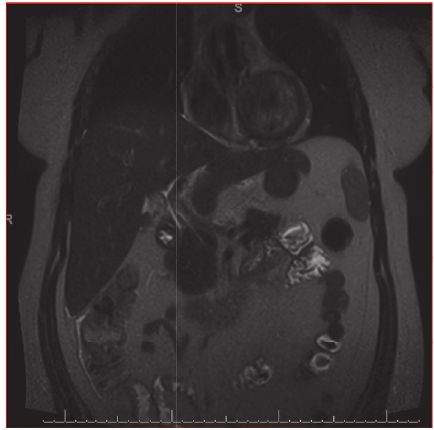
Figure 7: Postintervention MRCP revealing stone extraction and resolution of previously seen fluid